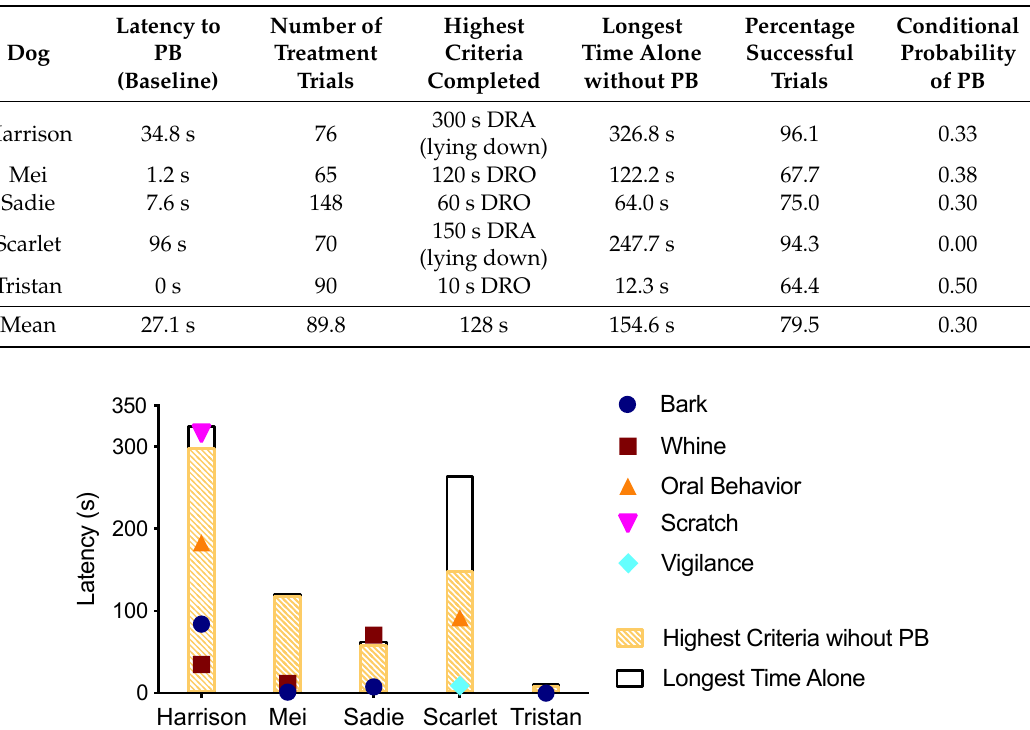
Table 3. Descriptive statistics of baseline and treatment. Longest time alone without problem behavior